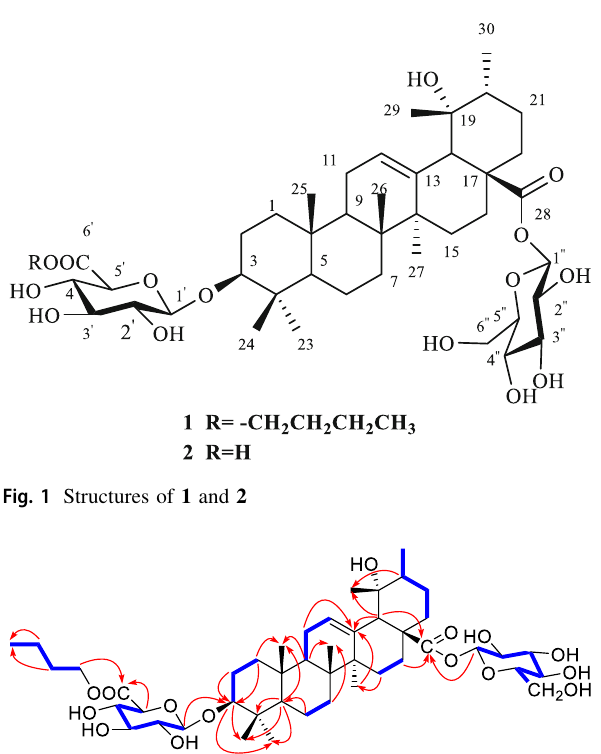
Fig. 2 Key 1 H- 1 H COSY (blue line) and HMBC (red arrow) correlations of compound 1